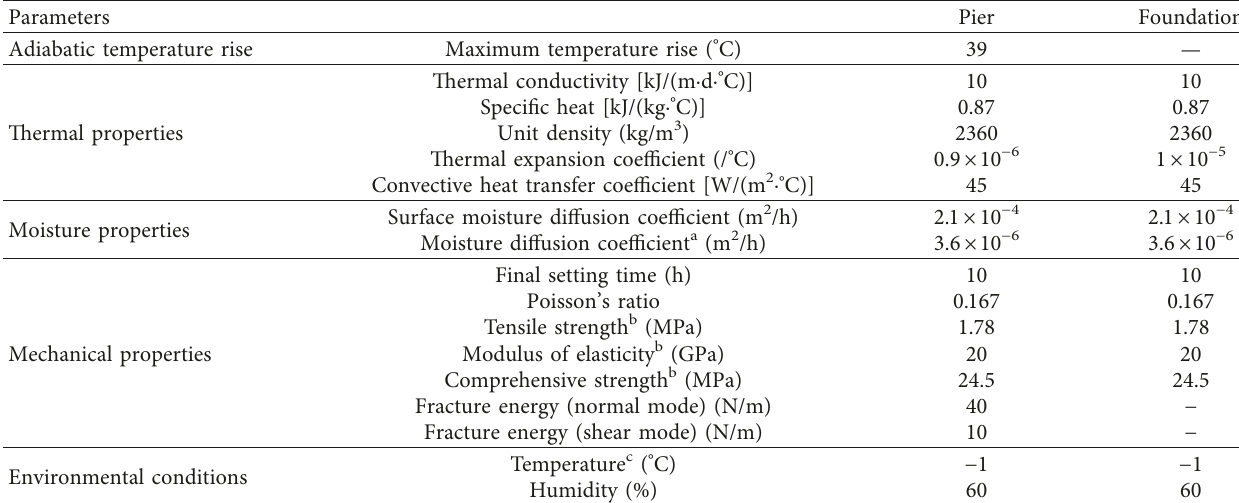
Figure 5: Structural configuration and data acquisition points. Table 2: Input data in numerical